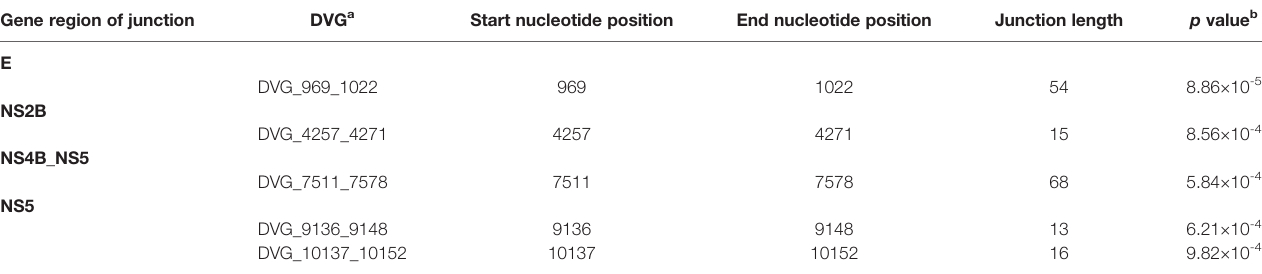
TABLE 2 | DVGs associated with disease severity in patients with DENV-2